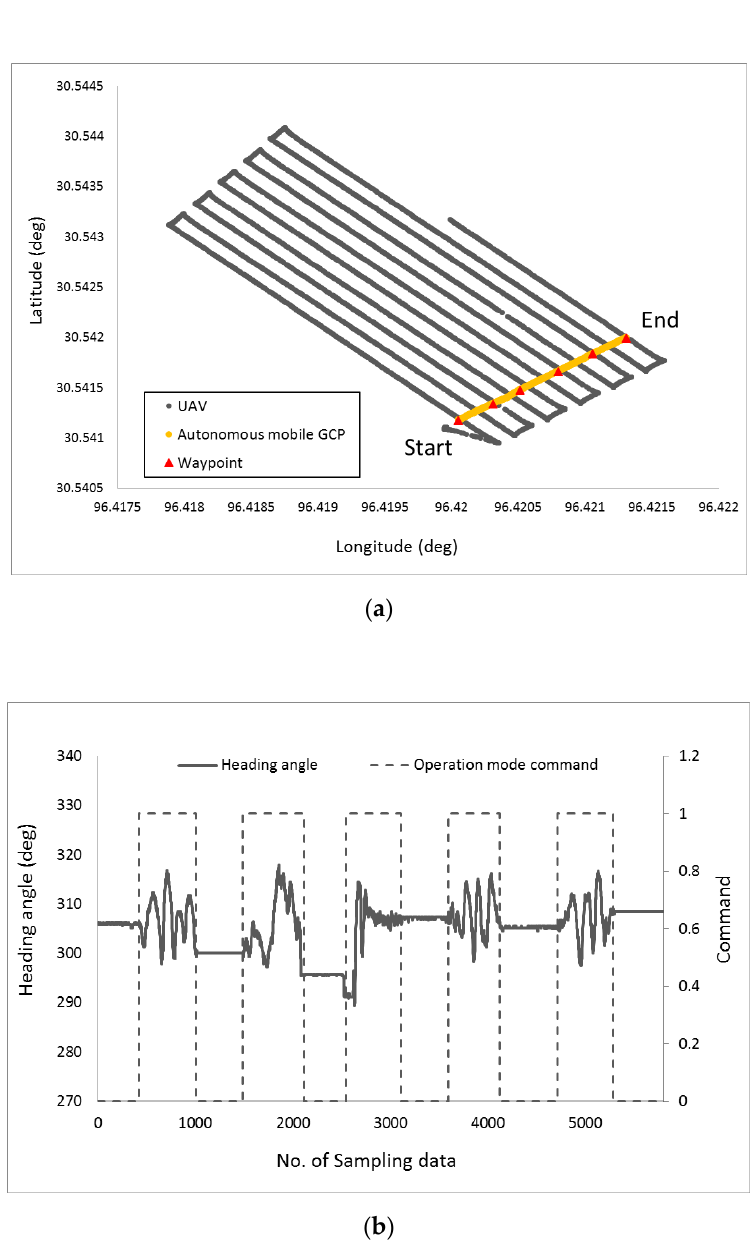
Figure 11. Trajectories of the UAV and the autonomous mobile GCP performing remote sensing in the field ( a ) and results of the heading angle and operation mode command recorded with the autonomous GCP during the flight ( b ).